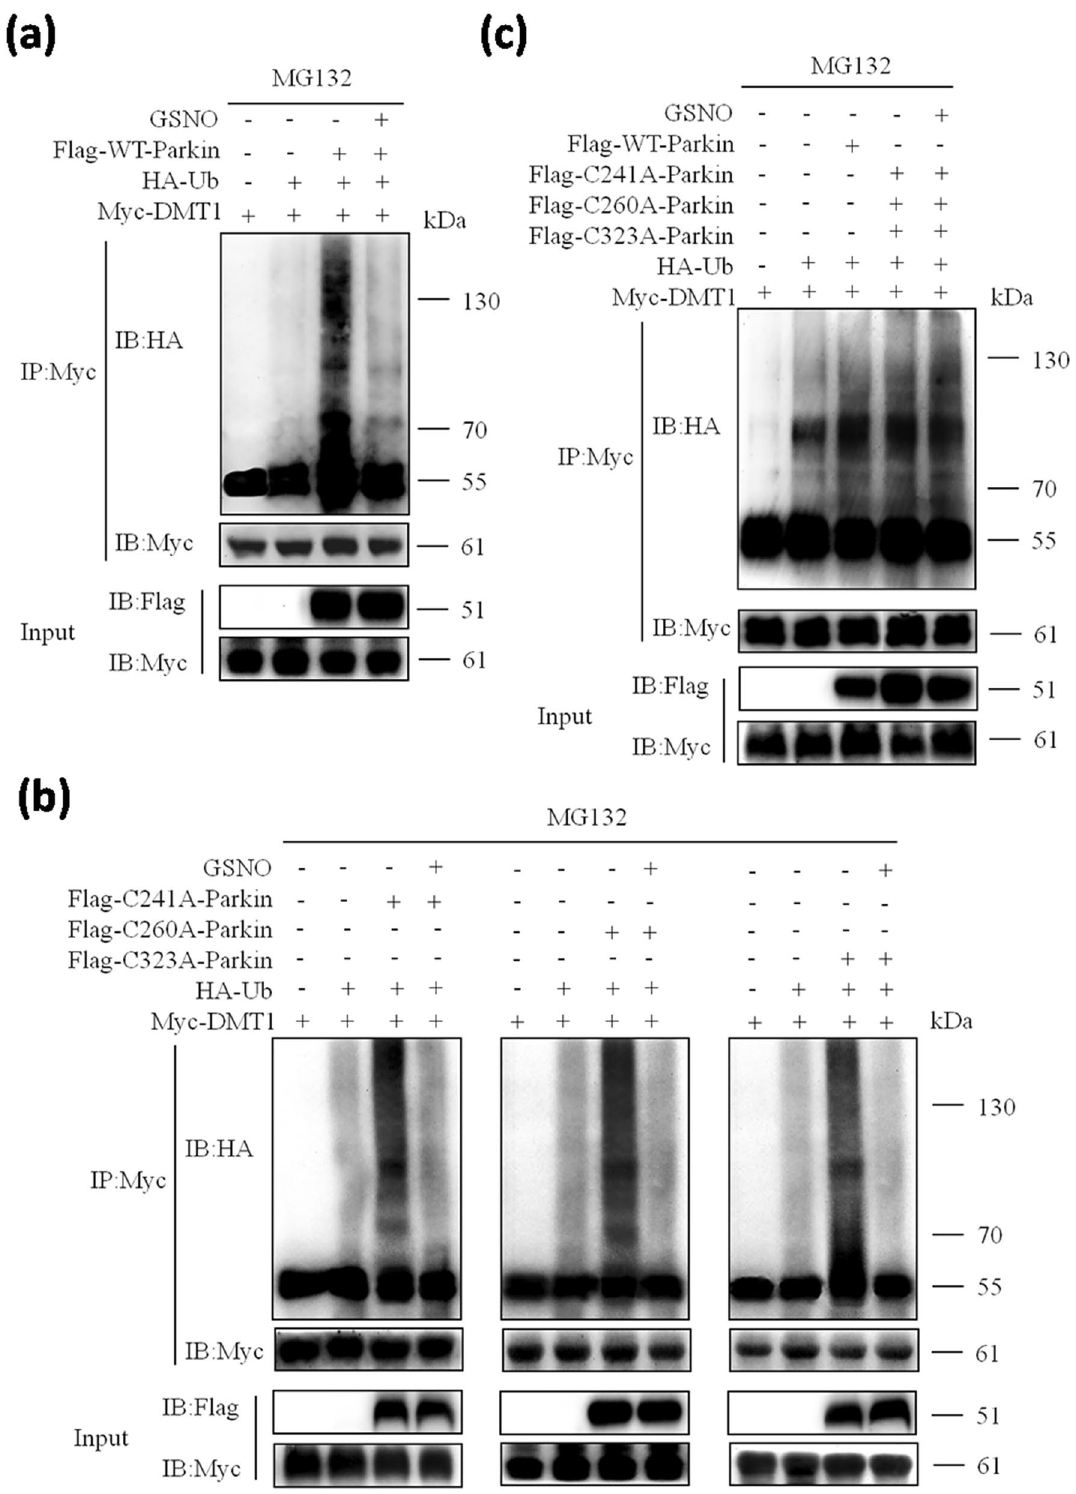
Figure 6. S-nitrosylation impaired the E3 ubiquitin ligase activity of parkin and inhibited the ubiquitination of DMT1. ( a ) WT-parkin was co-transfected with Myc-DMT1 and HA-Ub into HEK293T cells for 24 h. The ubiquitination of DMT1 presented. With the GSNO treatment, the ubiquitination of DMT1 was inhibited. ( b ) Single site mutant (Cys241A, Cys260A, Cys323A)-parkin was co-transfected with Myc-DMT1 and HA-Ub into HEK293T cells for 24 h. With the GSNO treatment, the ubiquitination of DMT1 was inhibited also. ( c ) Mutants (Cys241A, Cys260A, Cys323A)-parkin simultaneously, were co-transfected with Myc-DMT1 and HA-Ub into HEK293T cells for 24 h. With the GSNO treatment, the ubiquitination of DMT1 was not inhibited. Panels were representative of 3 independent